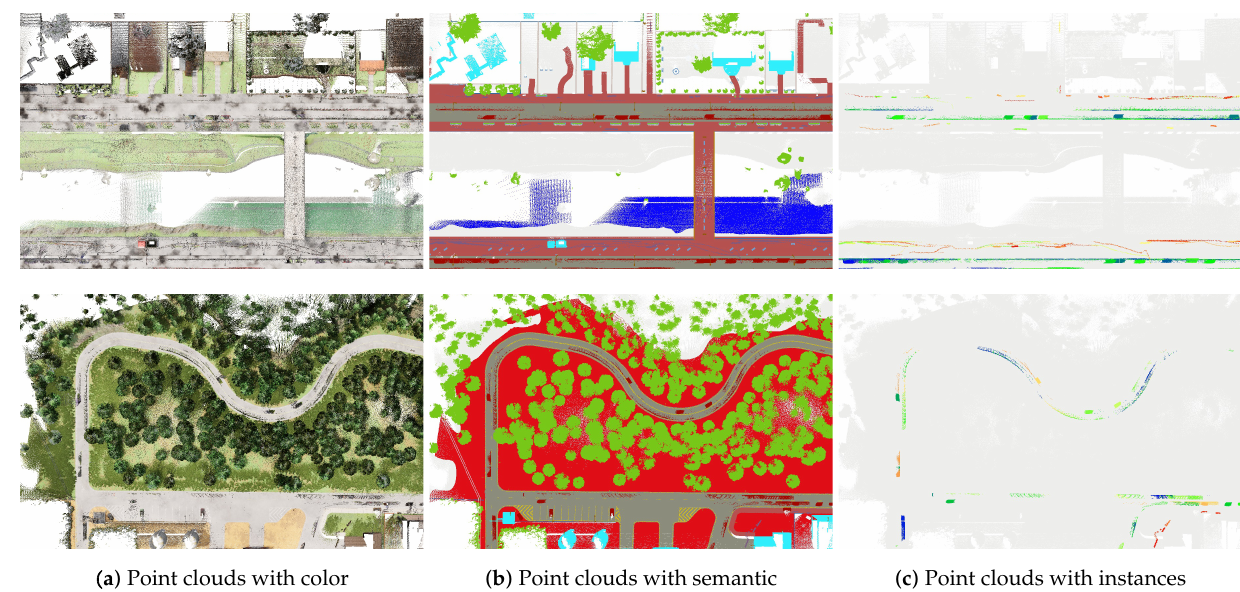
Figure A6. CARLA Test set . From top to bottom: T 1 , T 7 (synthetic data). Figure A6. CARLA test set. From top to bottom : T 1 , T 7 (synthetic